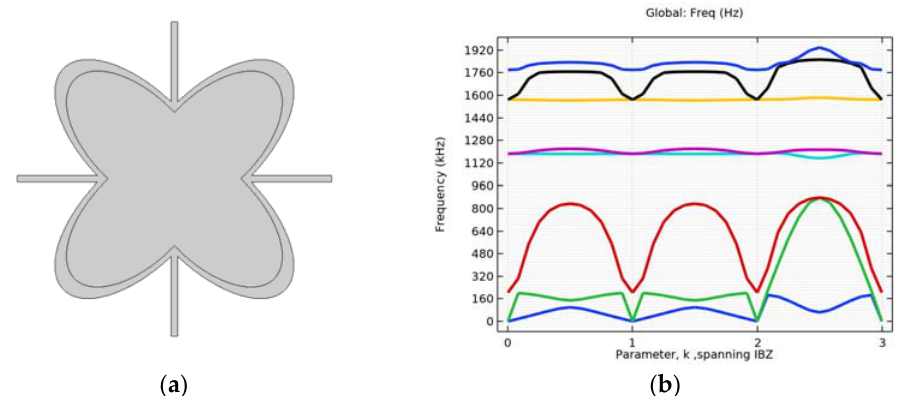
Figure 14. Response for inner ellipse 170 × 90, rod 6 mm. (a) microstructure, (b) responce for first eigenfrequenciew. Two band gaps exist, between 3rd and 4th eigenfrequency (840–1160 Hz) and between 5th and 6th eigenfrequency (1220–1570 Hz).